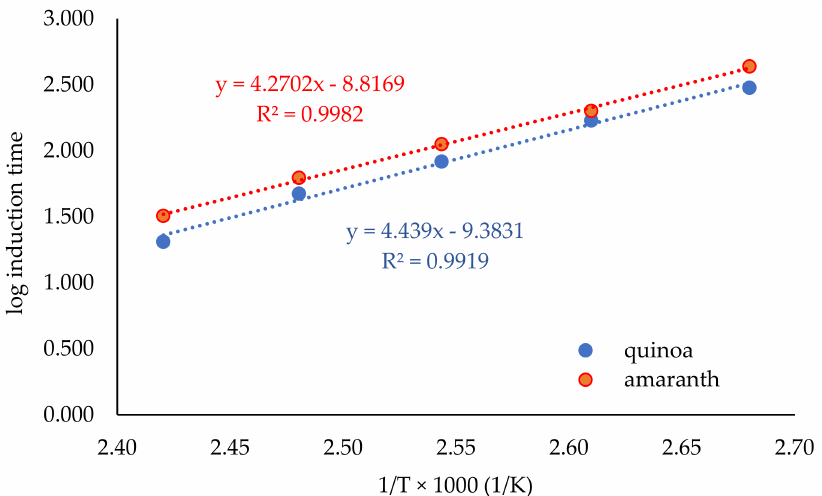
Figure 4. Log PDSC induction time ( τ ) versus reciprocal temperature for oxidation of amaranth (red line) and quinoa (blue line)